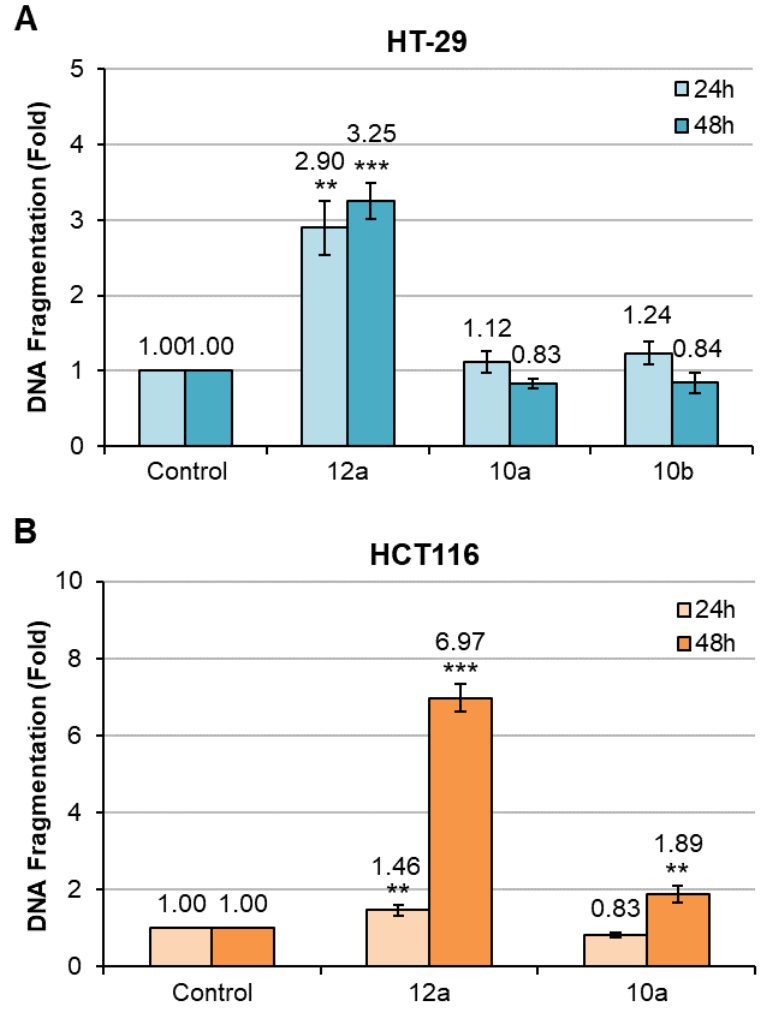
Figure 7. Effects of compounds 10a , 10b , 12a on DNA fragmentation in human CRC HT-29 cells ( A ) and effects of compounds 10a and 12a on DNA fragmentation in human CRC HCT116 cells ( B ). Data are shown as mean ± SEM (n = 3). ** p < 0.01 and *** p < 0.001.